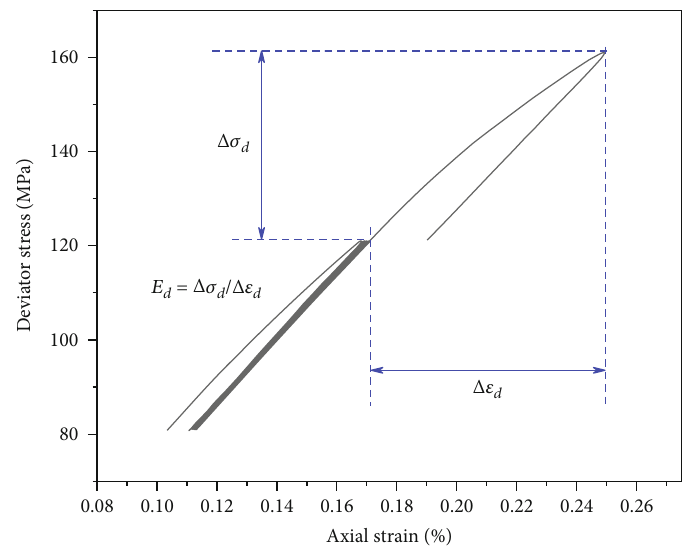
Figure 5: Calculation diagram of dynamic elastic